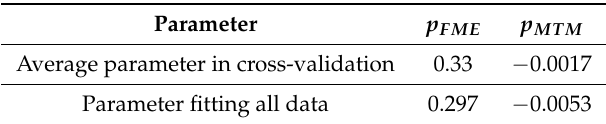
Table 3. Proposed model parameters. p FME stands for the FME signal coefficient in p and p MTM the coefficient for the MTM signal in p .